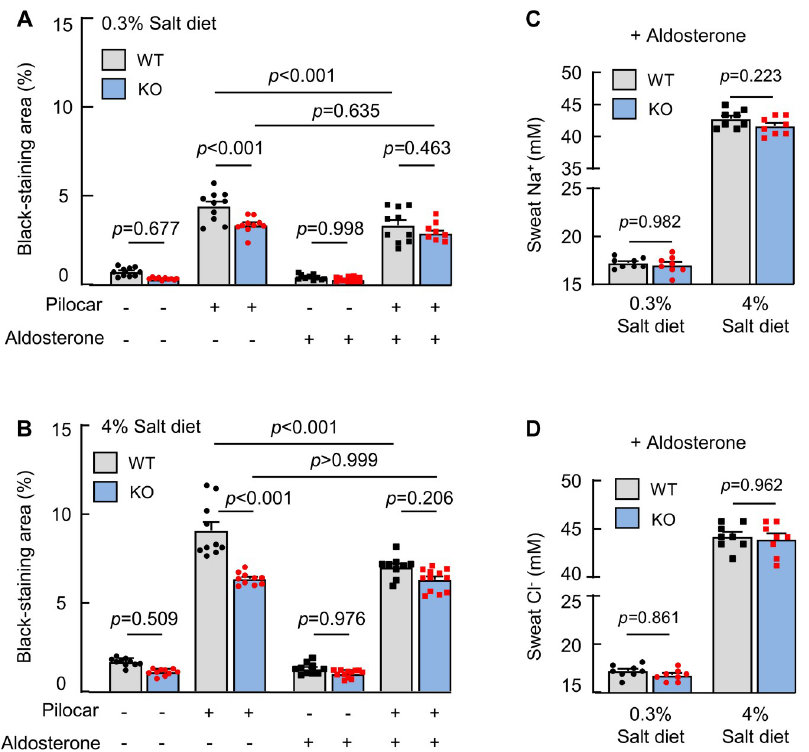
Fig 4. Effects of aldosterone on sweat and salt excretion. (A and B) Quantitative data (mean ± SEM) of black- staining areas in the iodine–starch test in WT and corin KO mice on 0.3% (A) or 4% (B) salt diet without ( − ) or with (+) aldosterone treatment and pilocarpine (pilocar) injection. (C and D) Sweat Na + (C) and Cl − (D) levels in WT and corin KO mice on 0.3% or 4% salt diet and treated with (+) aldosterone. Data are mean ± SEM. Each dot represents data from 1 mouse, except for sweat Na + and Cl − data, in which each dot represents data from 8 paws of 2 mice. P values were analyzed by 1-way ANOVA, and the original numerical values are in S1 Data. KO, knockout; WT, wild-